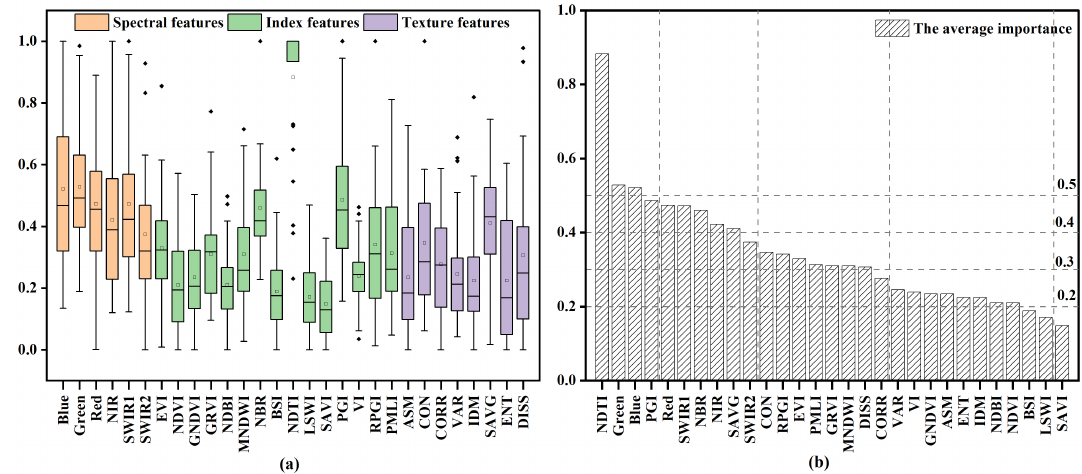
Figure 9. The importance of all features from 1989 to 2018: ( a ) the importance of each feature from 1989 to 2018; ( b ) the average importance of each feature over 30 years after ranking.